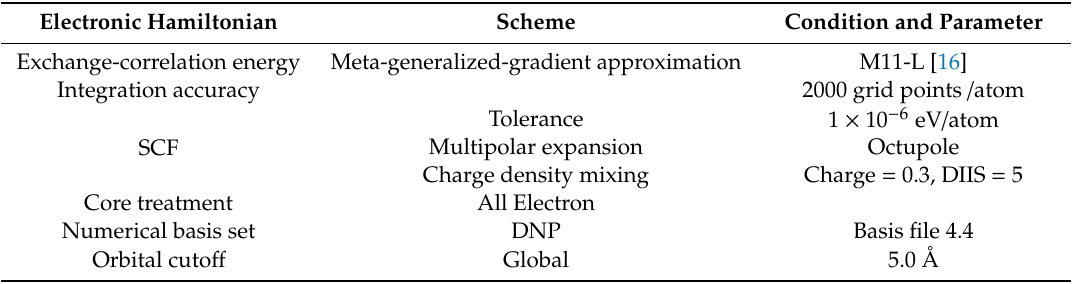
Table 2. Schemes and parameters adopted in the first-principles calculations of